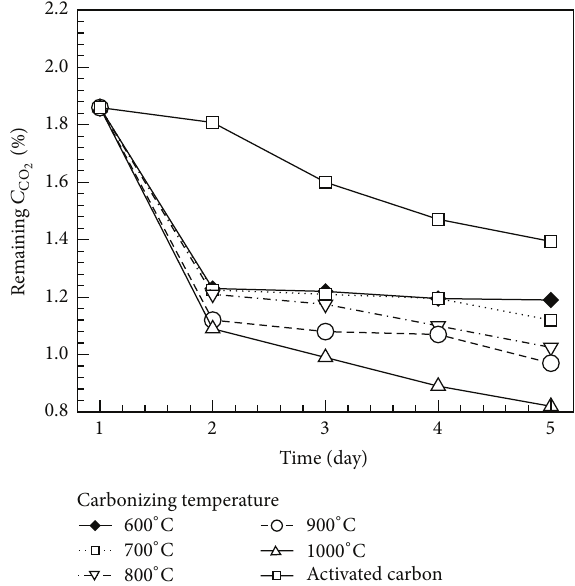
Figure 11: Remaining concentration of CO 2 as a function of adsorp- tion time for porous charcoal carbonized at various